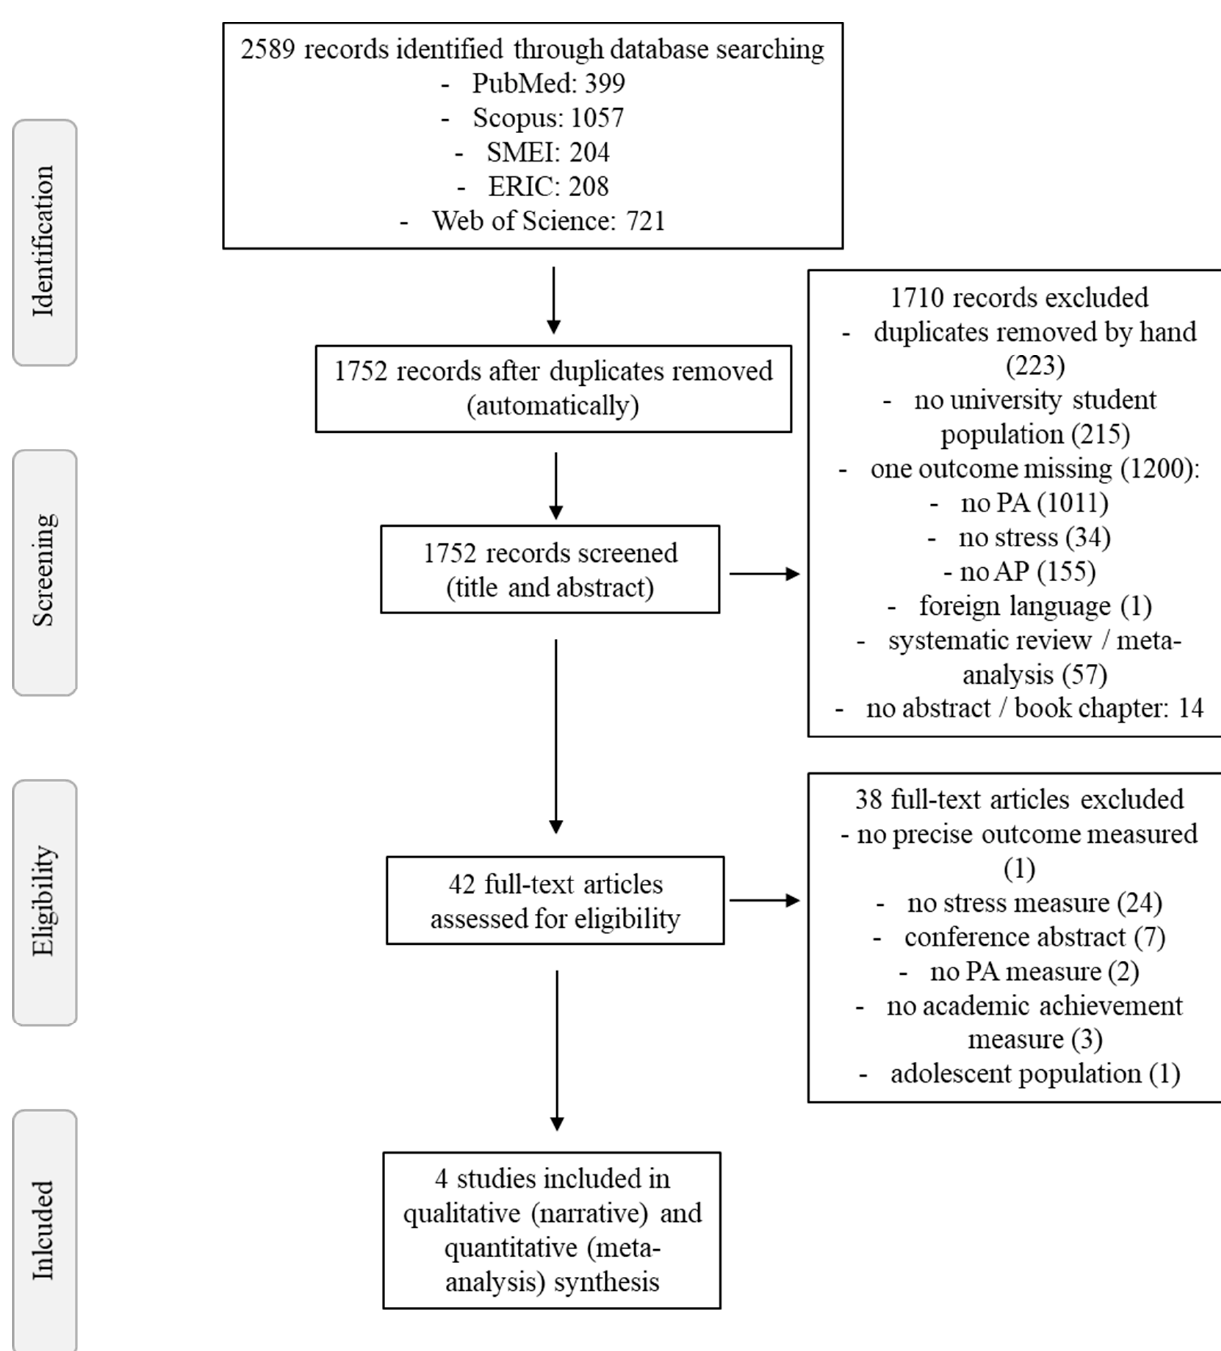
Figure 1. Flow chart of study selection process. Note: AP: academic performance; PA: physical activity.